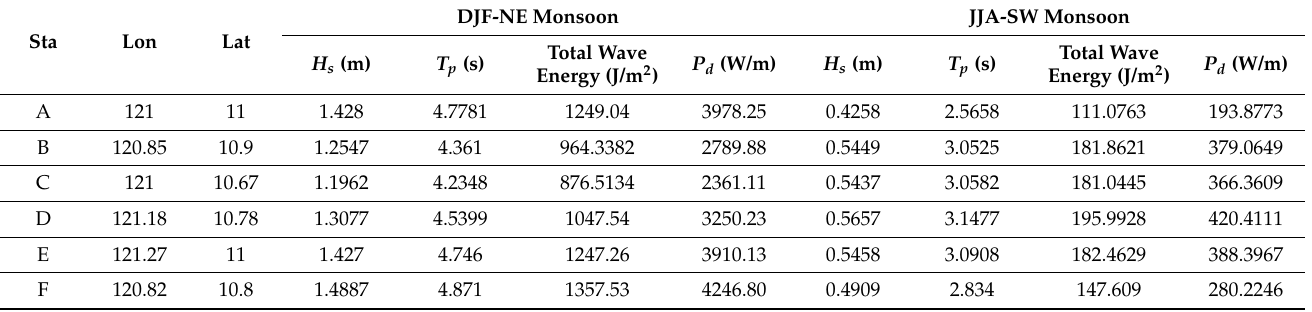
Figure 15. ( a ) H s (m) model during northeast monsoon season and ( b ) H s model indicating the average H s at stations A–F.